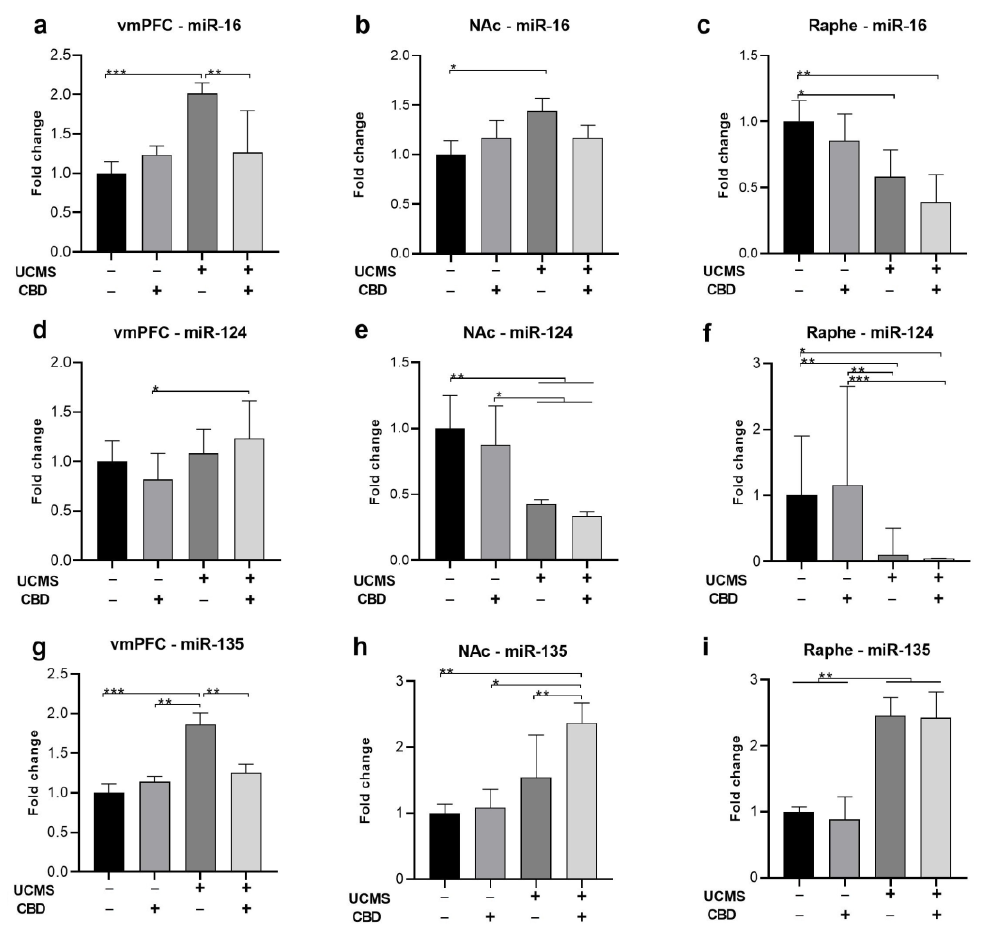
Figure 2. The effects of CBD treatment on miRNA expression in the vmPFC, NAc, and raphe nucleus in rats exposed to UCMS. miR-16. ( a ) vmPFC: UCMS rats treated with a vehicle demonstrated miR-16 upregulation compared to all groups. ( b ) NAc: UCMS rats treated with a vehicle demonstrated miR-16 upregulation compared to No UCMS rats treated with a vehicle. ( c ) Raphe: UCMS (vehicle, CBD) downregulated miR-16 compared to UCMS rats treated with a vehicle. miR-124: ( d ) vmPFC: UCMS rats treated with CBD demonstrated miR-124 upregulation compared to No UCMS rats treated with CBD. ( e ) NAc: UCMS downregulated miR-124 compared to No UCMS. ( f ) Raphe: UCMS downregulated miR-124 compared to No UCMS. miR-135: ( g ) vmPFC: UCMS rats treated with a vehicle demonstrated miR-135 upregulation compared to all groups. ( h ) NAc: UCMS rats treated with CBD demonstrated miR-135 upregulation compared to all groups. ( i ) Raphe: UCMS upregulated miR-135 compared to No UCMS. vmPFC: ventromedial prefrontal cortex; NAc: nucleus accumbens; miR: microRNA; UCMS: unpredictable chronic mild stress; CBD: cannabidiol. *, p < 0.05, **, p < 0.01, ***, p <